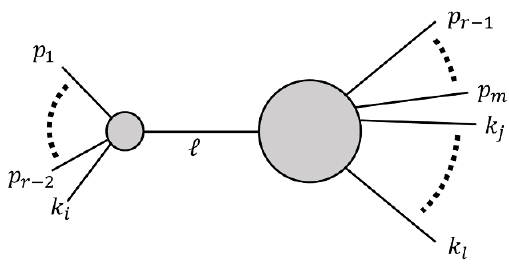
Figure 7. An example of pole diagram, with a r -point